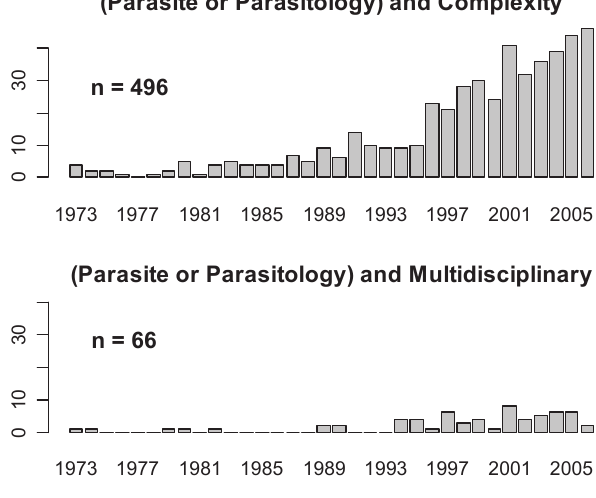
Fig. 1. – Number of articles from 1973 to 2006 indexed on Parasite, Parasitology, Complexity and Multisciplinary (Scopus ©